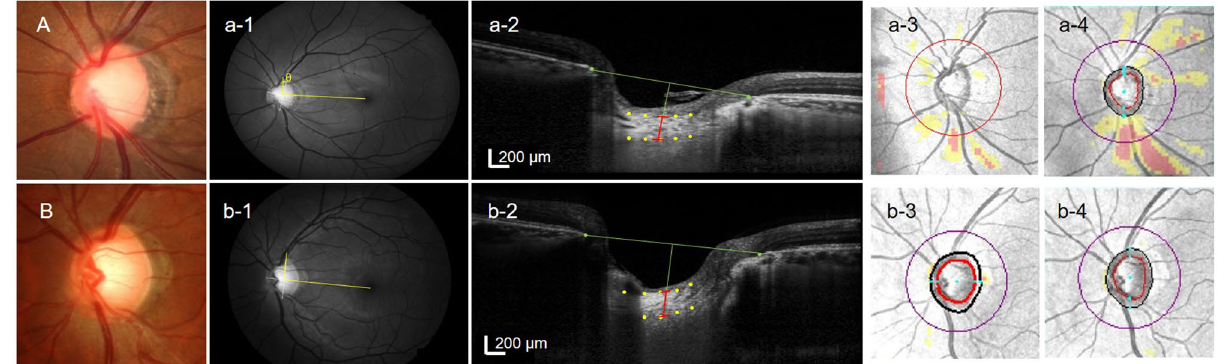
Figure 3. Representative cases showing the thinner lamina cribrosa (LC) contributes to normal-tension glaucoma (NTG) conversion in NTG suspects. ( A ) , A 62-year-old male with large cup-to-disc ratio in the left eye who had been follow-up for 9 years. Optic nerve head scan shows laminar cribrosa thickness of 127 μm. Progression to NTG was detected by the presence of localized retinal nerve fiber layer defect at the superotemporal region ( a-2 ) compared to baseline ( a-1 ). ( B ) , A 63-year-old male with large cup-to-disc ratio and neuroretinal rim thinning in the right eye who had been follow-up for 10 years. Optic nerve head